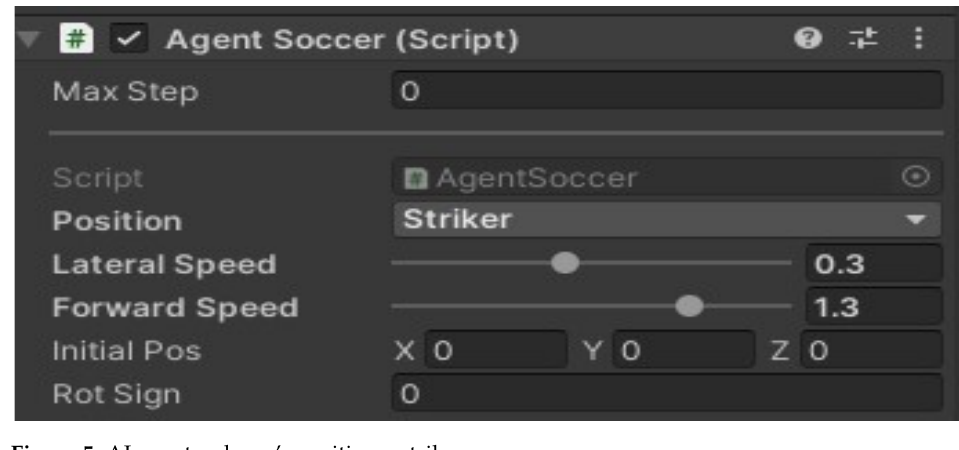
Figure 5. AI agent − player’s position—striker. Figure 5. AI agent - player’s position—striker. Figure 5. AI agent - player’s position—striker. Figure 5. AI agent - player’s position—striker.